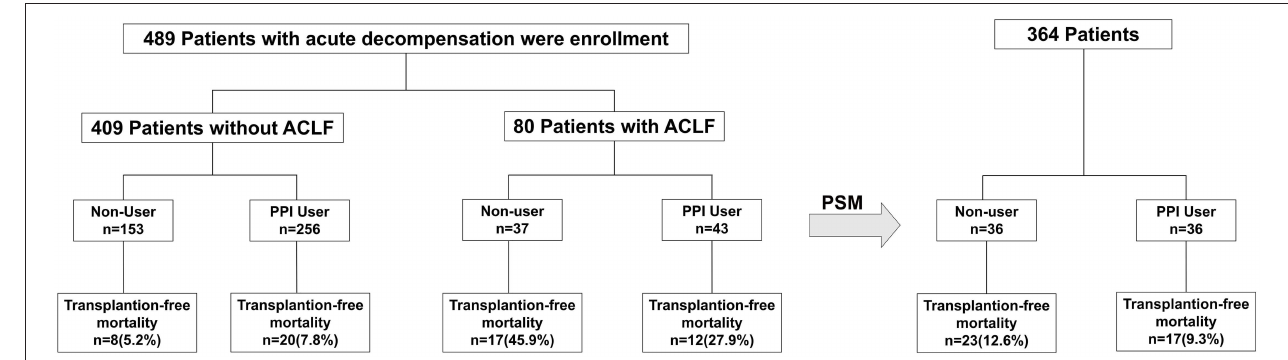
FIGURE 1 | Flowchart showing patient selection for the study. A total of 489 acute decompensated patients with liver cirrhosis were selected and then propensity score matched with 1:1. PPI, proton pump inhibitor; ACLF, acute-on-chronic liver failure.